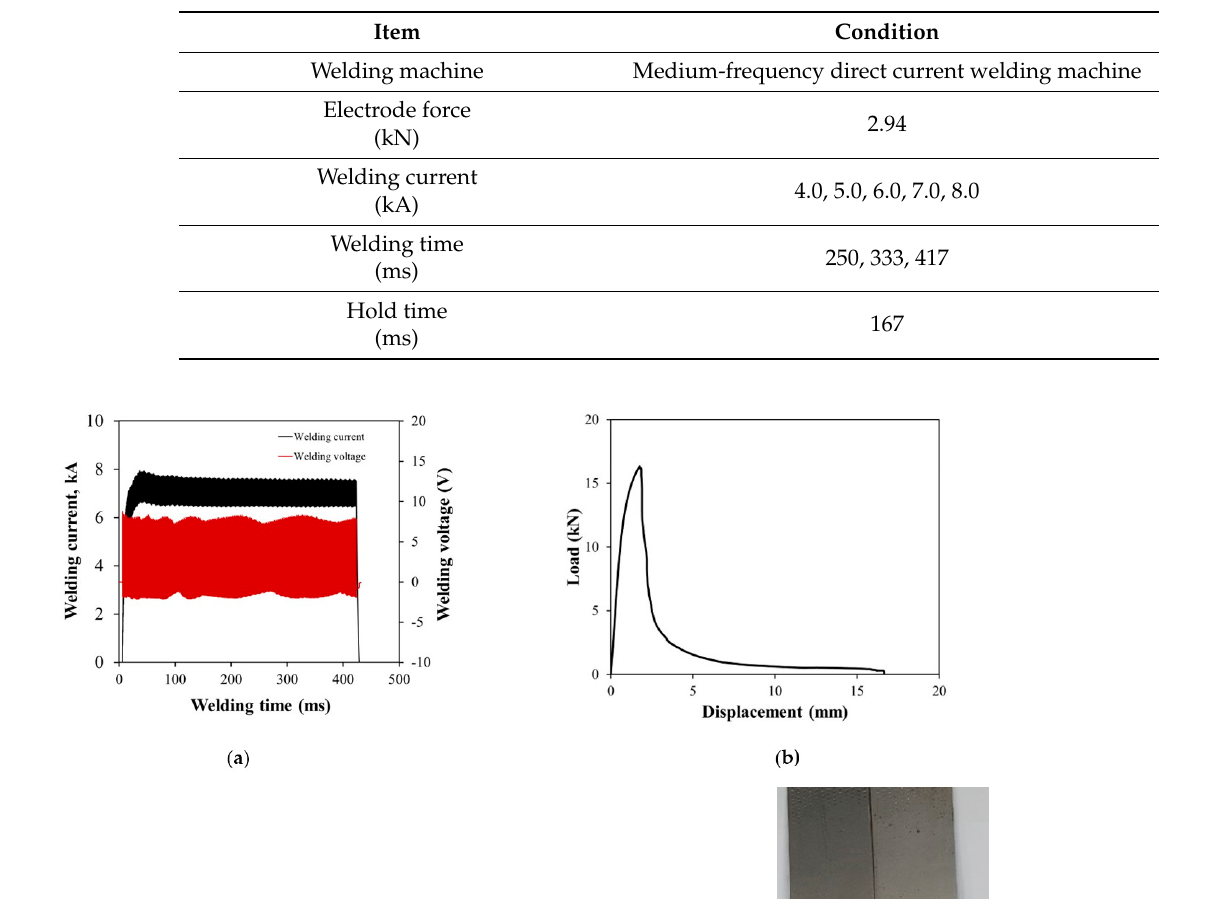
Table 2. Welding conditions.